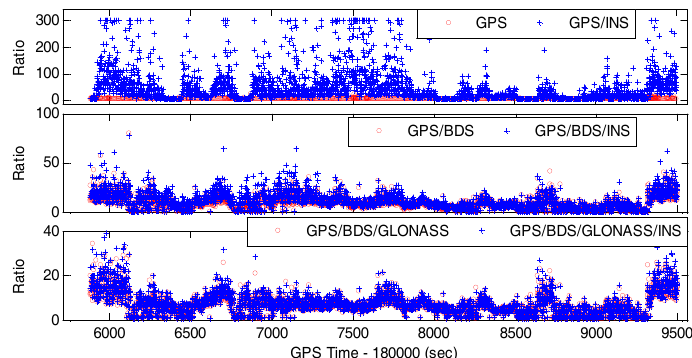
Figure 8. Ratio values of single-epoch AR for different system configurations (15° cut-off elevation angle).